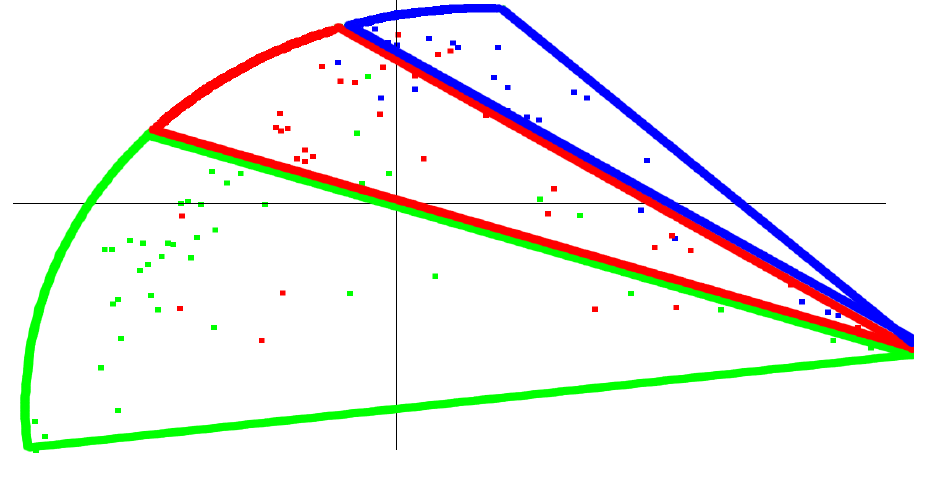
Figure 3. Clustering using the wavelet-based method. Green corresponds to high wavelet-based statistics. Red corresponds to medium values, while blue corresponds to small values.